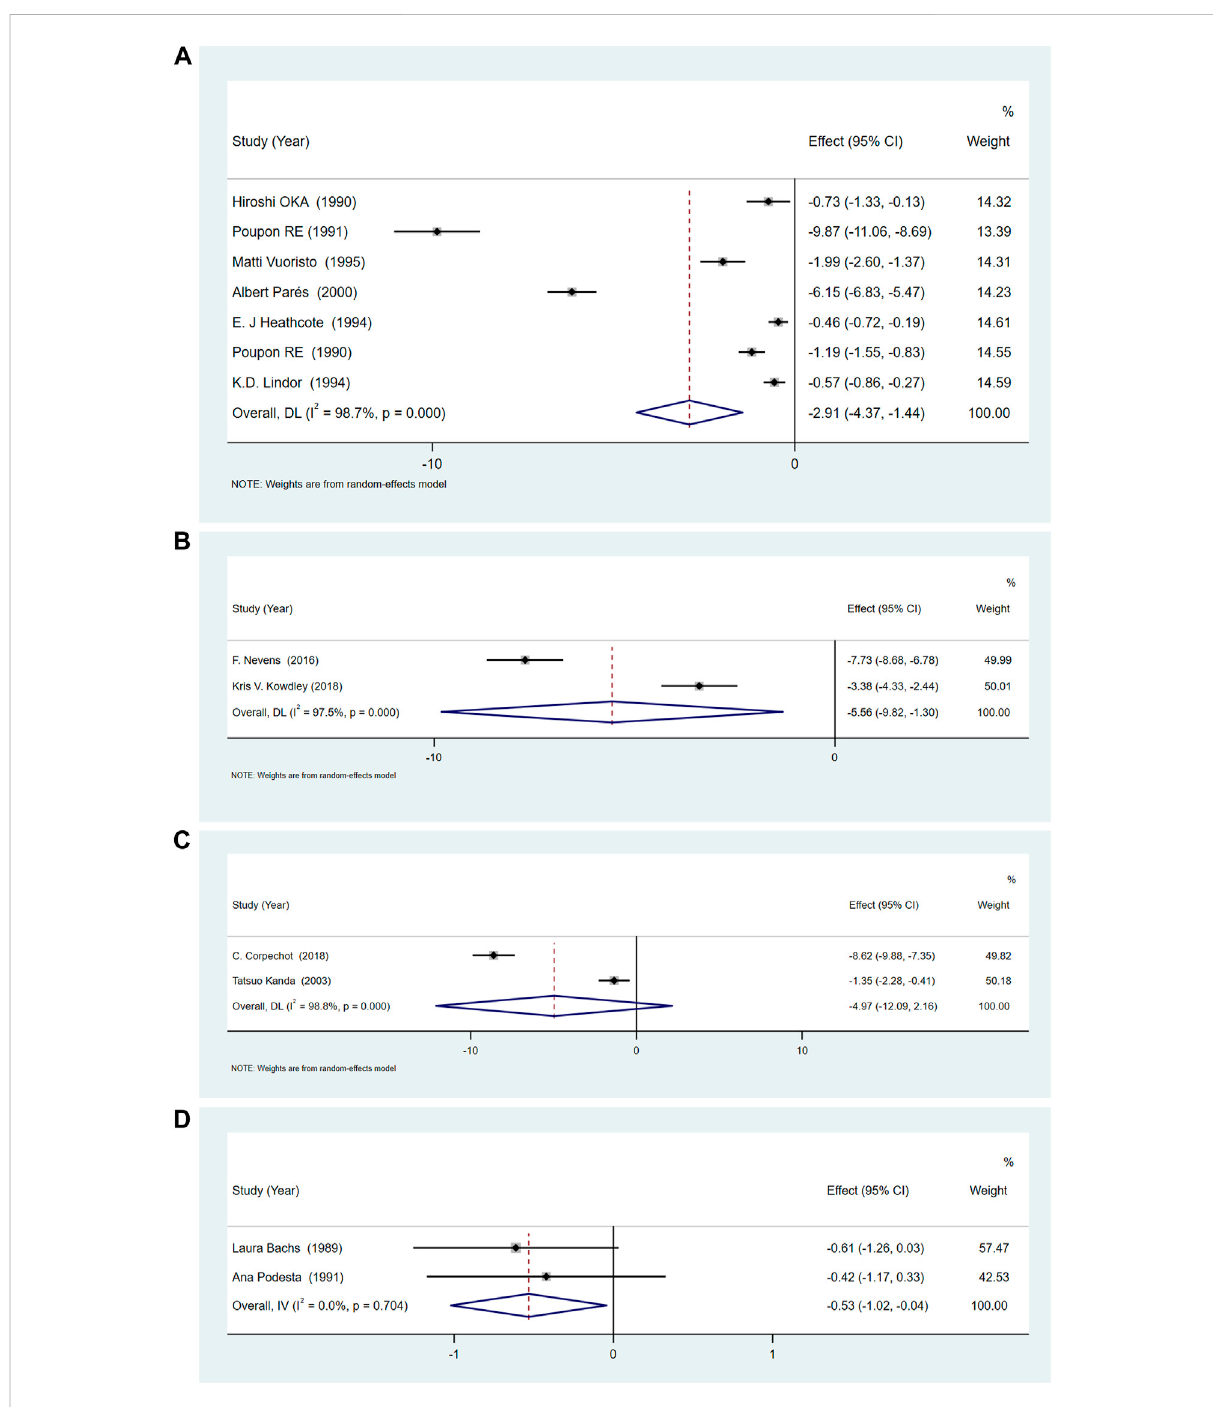
FIGURE 4 (A) The effect of UDCA in serum ALP. (B) The effect of OCA on serum ALP. (C) The effect of Beza fi brate on serum ALP. (D) The effect of Rifampicin on serum